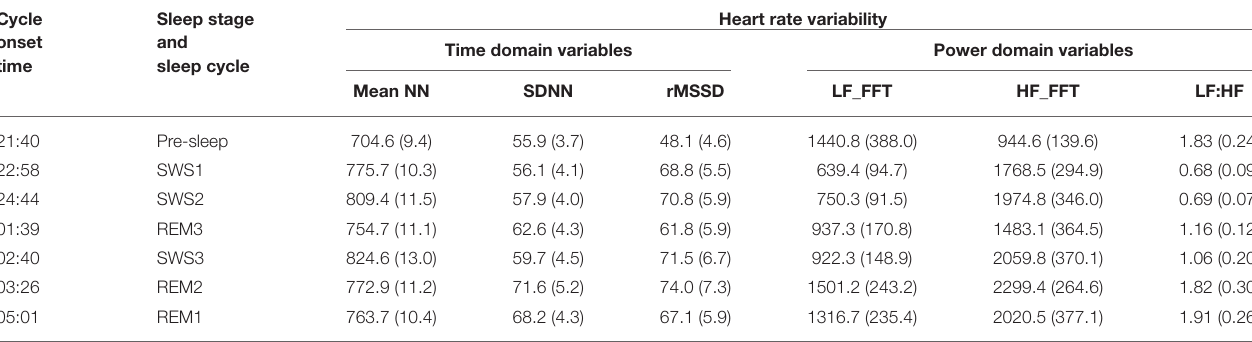
Heart rate variability